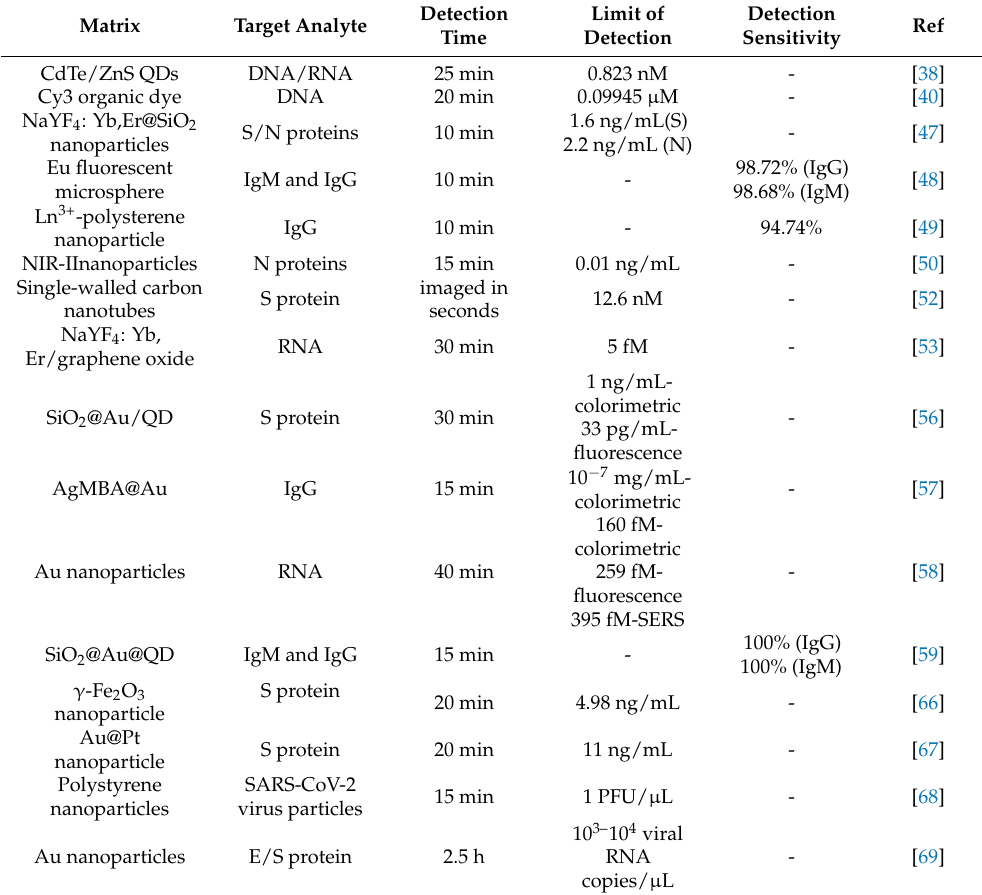
Table 1. Matrix, target analyte, detection time, limit of detection, and detection sensitivity of the latest fluorescence